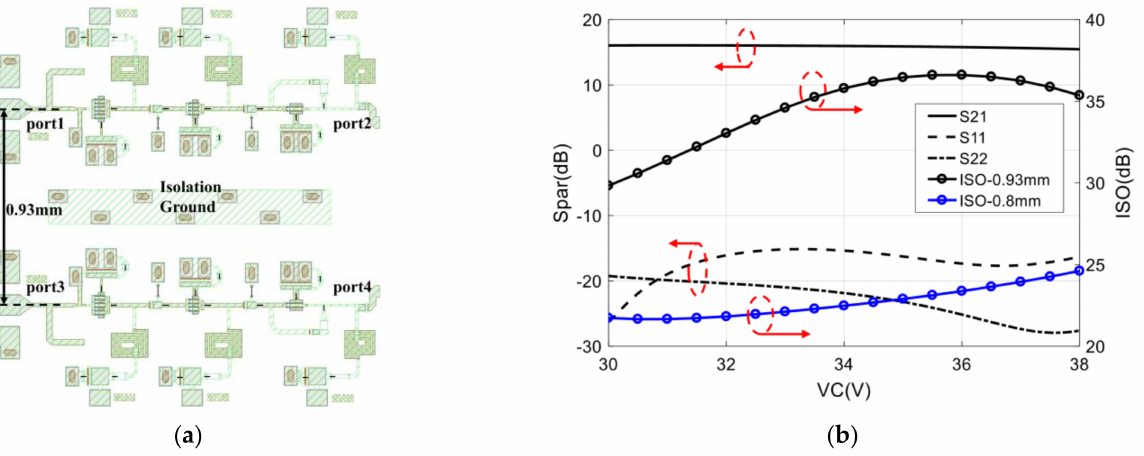
Figure 8. The layout design and the simulation results of the proposed two amplifiers: ( a ) The production stage layout design; ( b ) The simulation